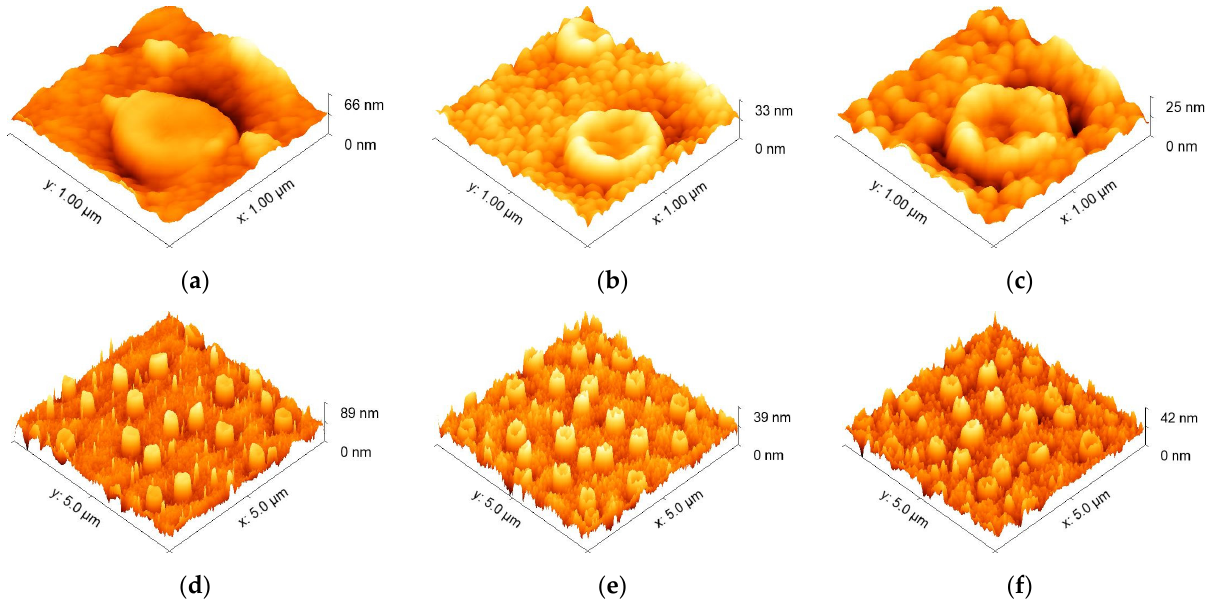
Figure 7. AFM images of the polymer foils deposited with TiO 2 + Ag films ( a , d ), SiO 2 + TiO 2 ; ( b , e ), SiO 2 + Ag; ( c , f ); all films have a total thickness of ~33 nm. The images grouped by type of thin film correspond to the same sample and were obtained at different scanning areas.